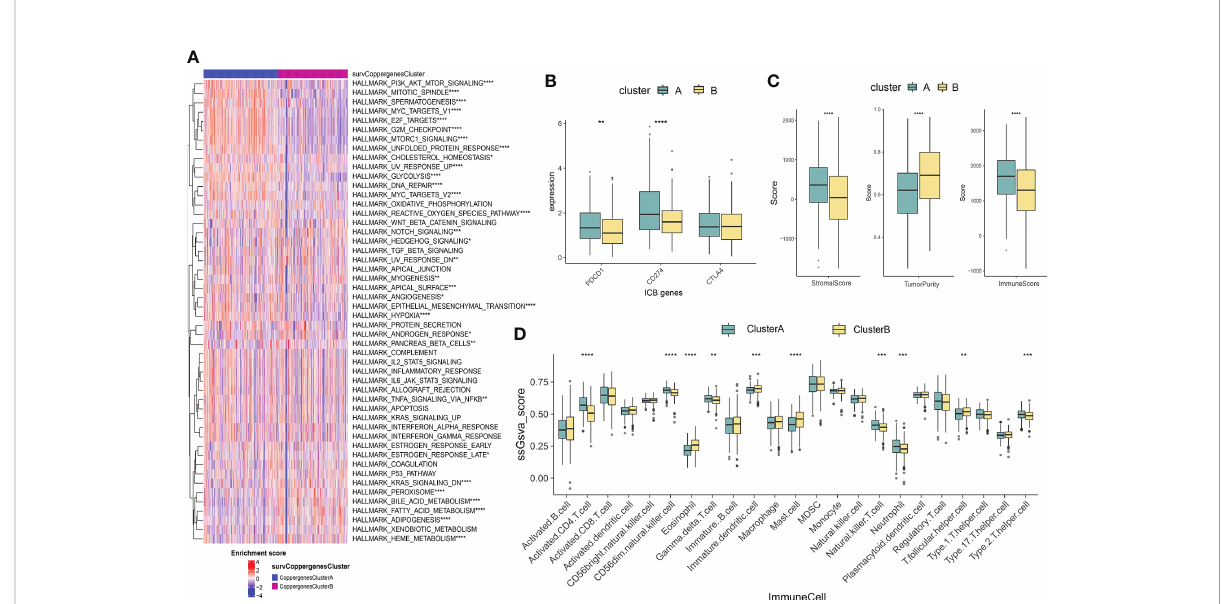
FIGURE 3 Characteristics of the TME between the two consensus clusters. (A) GSVA of biological pathways between two consensus clusters, in which red represent activated and blue represent inhibited pathways, respectively. (B) Expression levels of PDCD1 (PD-1), CD274 (PD-L1), and CTLA4 in the two consensus clusters. (C) Correlations between the two consensus clusters and TME score (stromal score, tumor purity, and immune score). *P<0.05, **P<0.01, ***P<0.001, **** P<0.0001. (D) Abundance of 23 in fi ltrating immune cell types in the two consensus clusters. GSVA, gene set variation analysis; TME, tumor